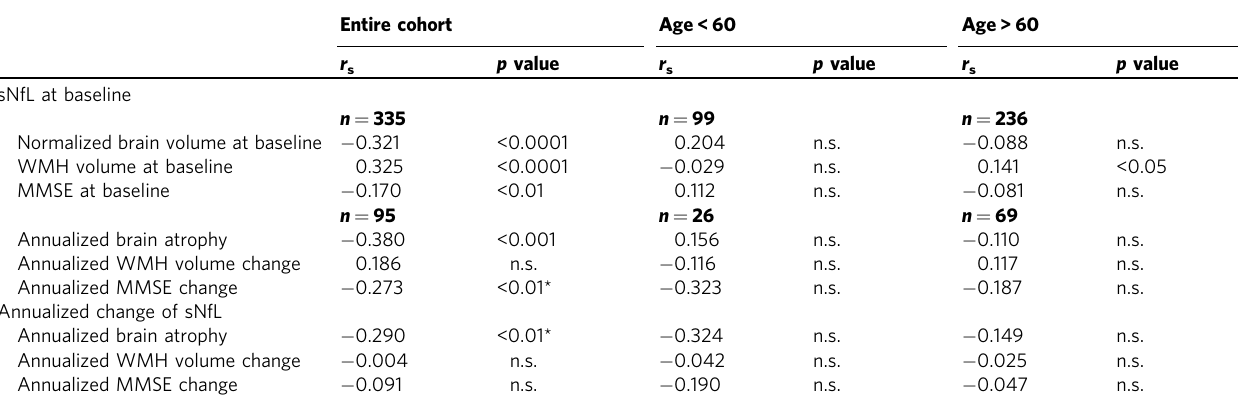
Table 4 Results of univariate analysis applying Spearman partial correlation between sNfL levels and morphologic data, with and without consideration of age effects.